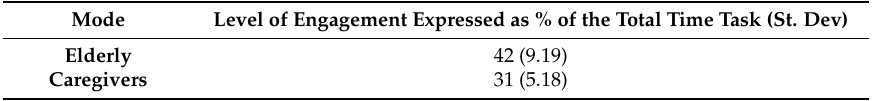
Table 2. The level of user engagement during shared-control—mean values and standard deviation.